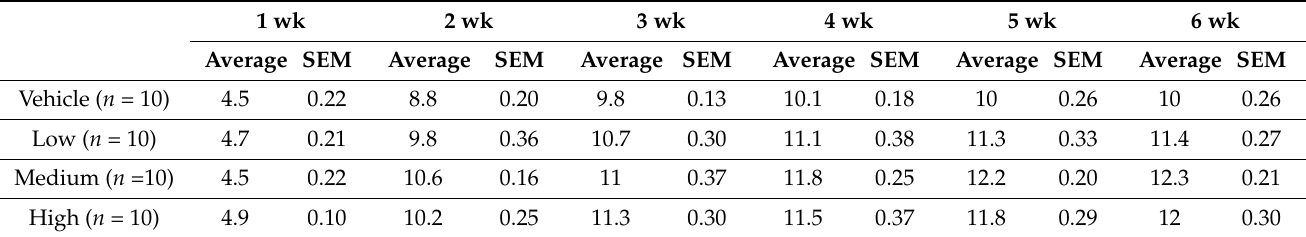
Table 1. BBB scores for each of the experimental